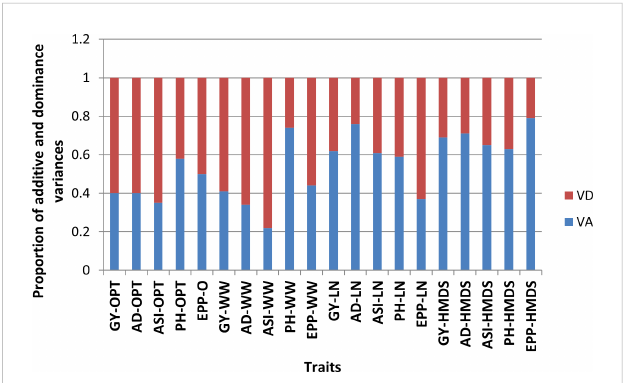
FIGURE 2 Proportion of additive (VA) and dominance (VD) variance components for grain yield and other secondary traits under optimum (OPT), well- watered (WW), managed low nitrogen (LN) and heat and drought (HMDS)